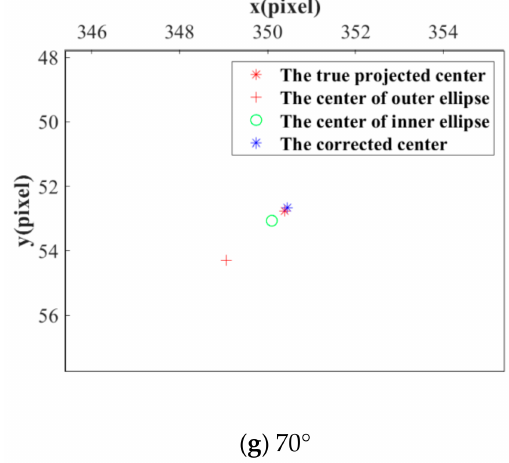
Figure 13. The center positioning results for different viewing angles: ( a ) 10 ◦ ; ( b ) 20 ◦ ; ( c ) 30 ◦ ; ( d ) 40 ◦ ; ( e ) 50 ◦ ; ( f ) 60 ◦ ; ( g ) 70 ◦ . The red “+” and green “o” represent the centers of the outer and inner ellipses detected by fitting method; the blue ‘*’ represents the CCCT corrected center obtained by our method; the red ‘*’ is the location of the true projected center.